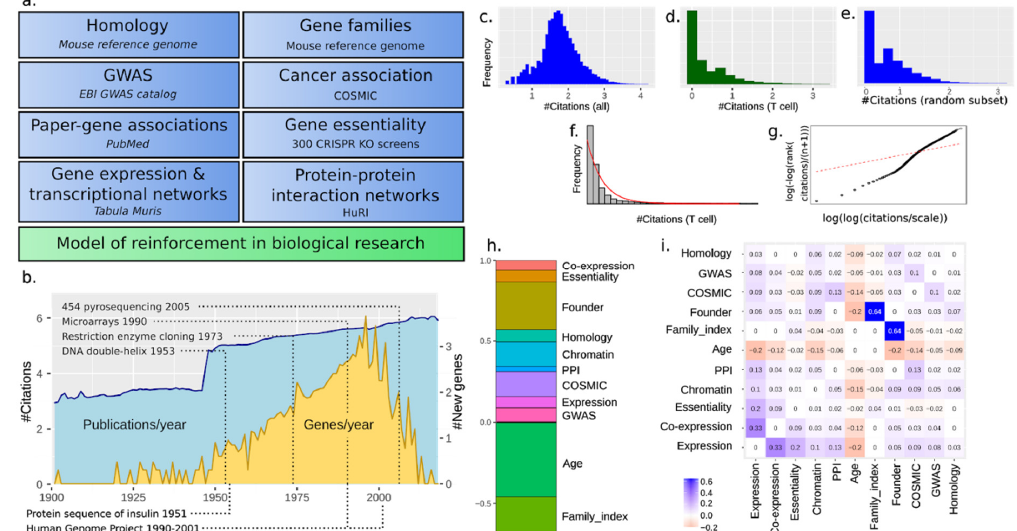
Figure 1. ( a ) Features defining the total model of reinforcement and the datasets used. ( b ) Citations and discovered genes over time, along with landmark events in genomic biology research. #Citations are log10(number of citations + 1). #New genes are log10 (number of genes + 1). Gene citation count distributions for all cell types ( c ) and for T lymphocytes ( d ). Overall gene publication frequencies follow a log-normal-like distribution, while when applying a cellular-type context, a Pareto-like trend appears. ( e ) Random subset of papers, similar to the number of papers for T cells in d. ( f ) A fit with an exponential distribution. This shows the super-exponential nature of citations. ( g ) Fit with the pareto distribution. This shows similarities but not a perfect fit either. We conclude that citations follow some intermediate distribution between these two cases. ( h ) Features and their relative weight contribution to the total fitted model. The order of features does not matter. Features do not sum to 1 but the input features are variance-normalized. Age is negative as we use the year of publication as a feature, which after normalization is negative age. ( i ) Spearman’s correlation coefficients between the included features for the total fitted model.